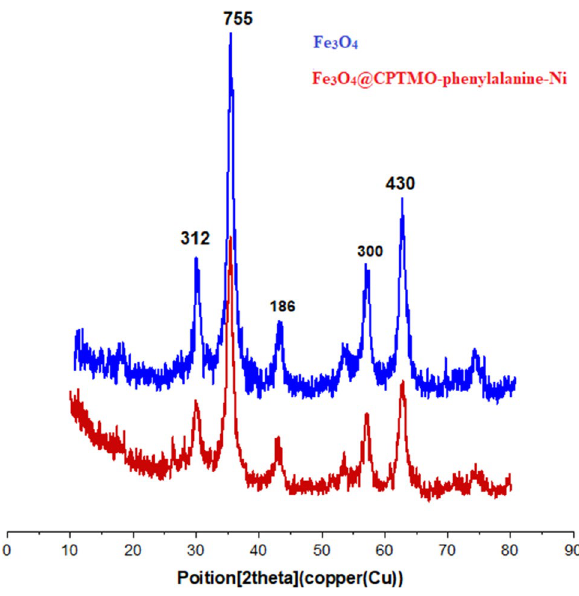
Figure 9. XRD pattern of Fe 3 O 4 and Fe 3 O 4